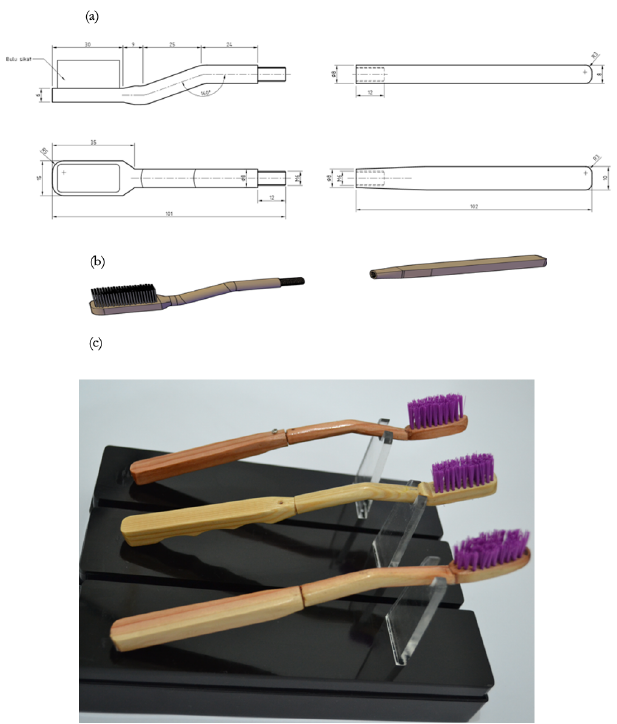
Figure 4. Wood waste toothbrush (a) Toothbrush design made from wood waste; (b) 3D wood waste toothbrush; (c) Prototype of wood waste